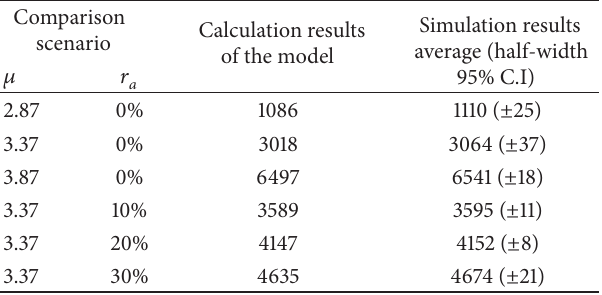
Table 5: Calculation results of the model of the maximum number of passengers in waiting room and simulation results.